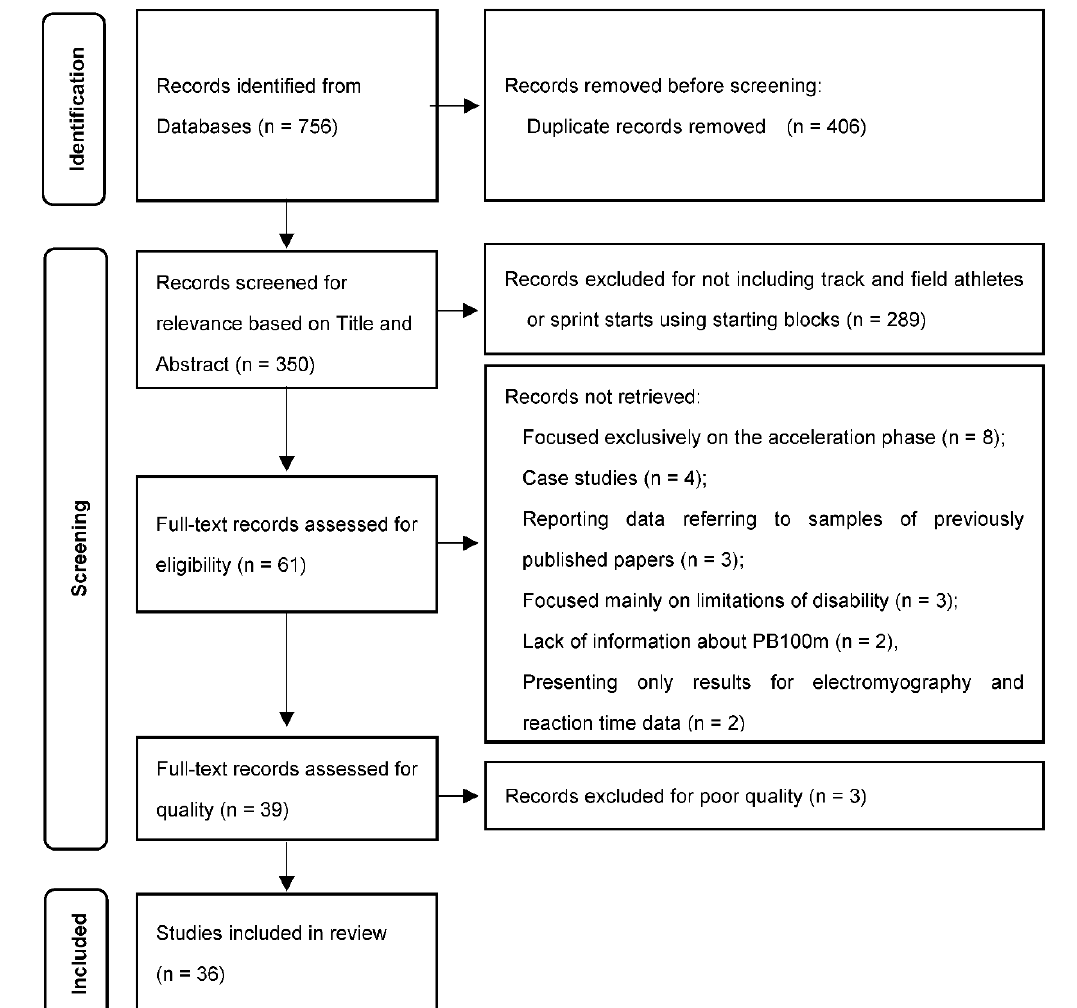
Figure 1. Flow diagram of the study selection process according to PRISMA guidelines.